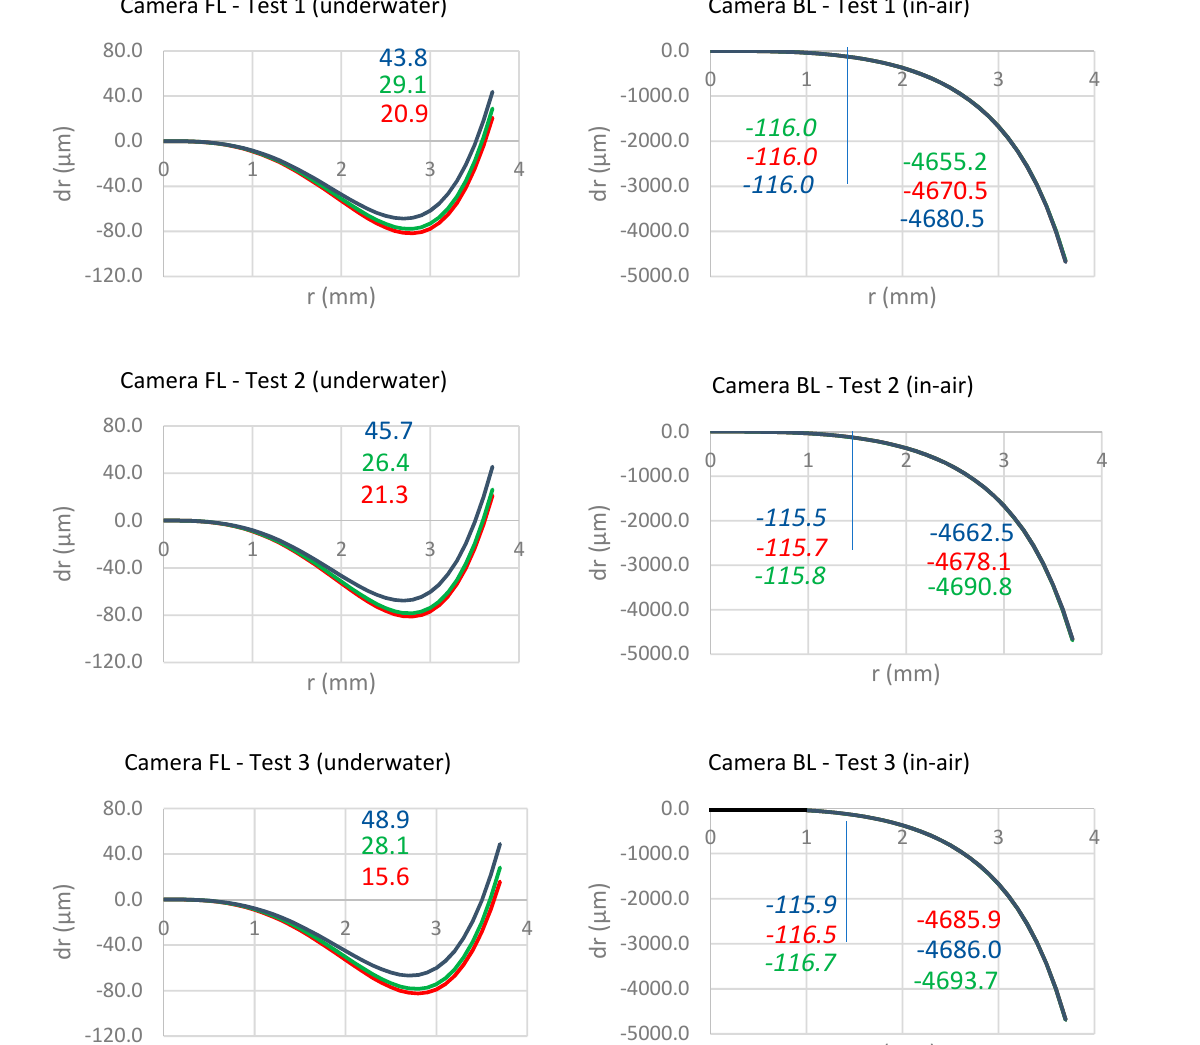
Figure 13. Comparison of the influence of the calculated radial lens distortion parameters for the camera FL underwater ( left column) and the camera BL ( right column) for the overall three repeats (rows). The colours indicate the results for the different bands (blue, green, red) using the CMB adjustment. Black indicates that the bands are so close to each other that the difference cannot be shown. The coloured non-italics numbers indicate the distortion in µm at the maximum radial distance. The italics numbers indicate the distortion in µm considering the scale change from underwater to in-air.